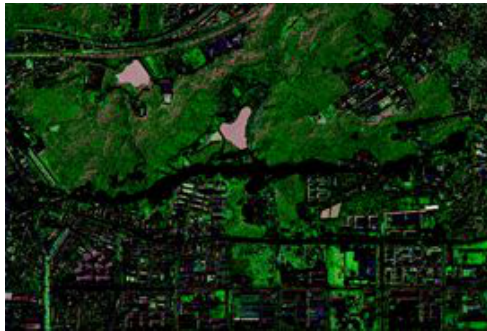
Figure 6. Krish edge detection